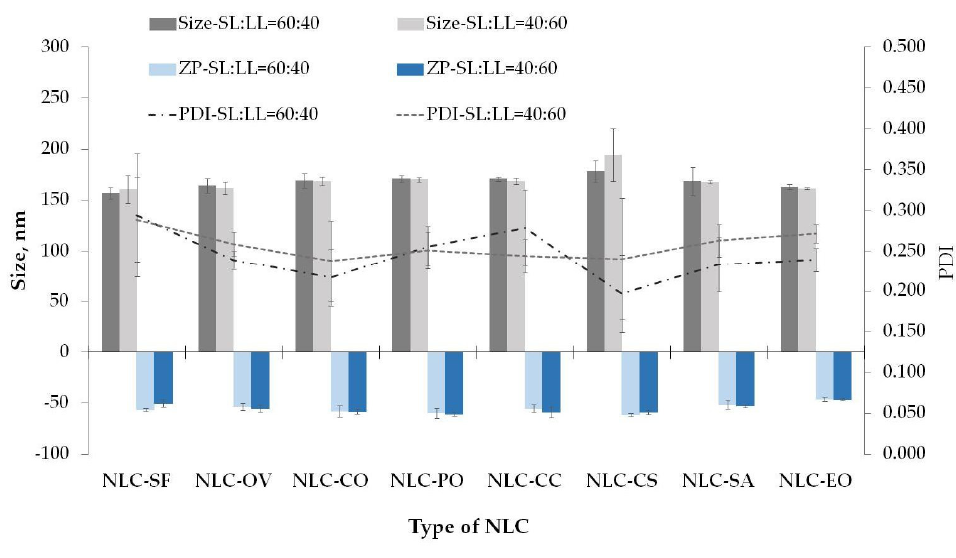
Figure 3. Physicochemical stability for NLC-NPOs after 24 h; Span 80, 2%, w / w . The obtained polydispersity indices (from 0.197 to 0.294 for all formulations) revealed the lipid nanoparticles’ relatively uniform size distribution (Figure 3). The acquired ZP values ranged between − 46.3 mV (NLC-EO; SL:LL = 60:40) and − 61.3 mV (NLC-CS; SL:LL = 60:40) and indicated high physical stability [11,12,49]. Physicochemical charac- terization was repeated after 7 days and 1 month (data not shown). During one month, for NLC-CC (SL:LL = 40:60; 4.1%). A maximum change for PDI (5.3%) was observed for NLC-